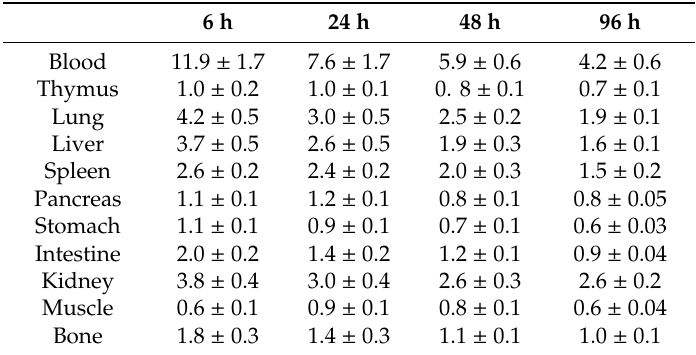
Table 2. Biodistribution of 111 In-labeled anti-CD73 antibody 063-213 in healthy rats.